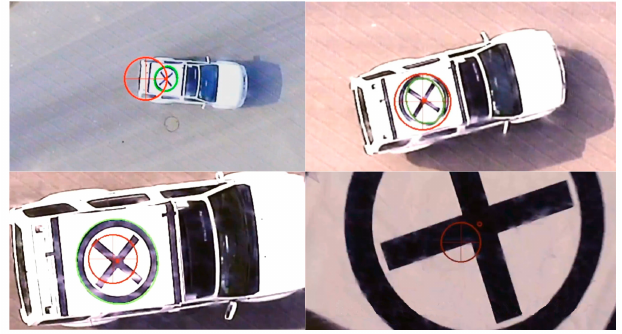
Figure 3. Vision-based detection of the moving target during the landing